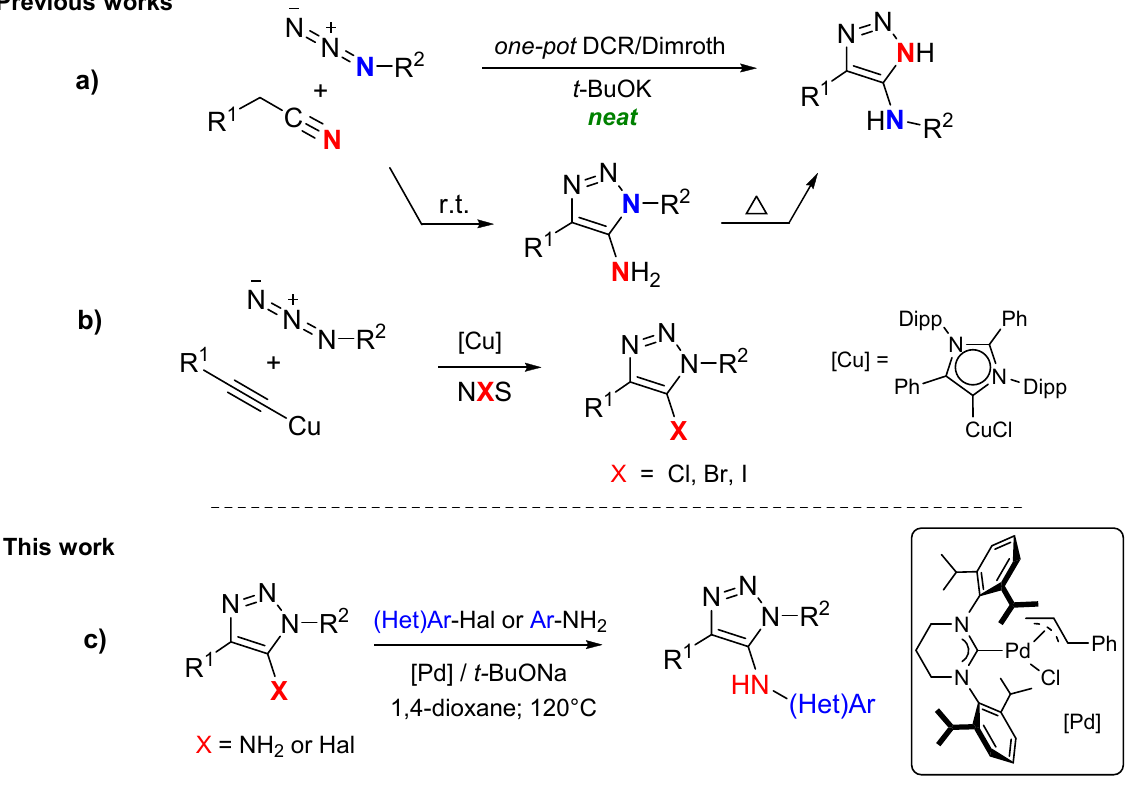
Scheme 2. Synthetic approach to 5-amino-1,2,3-triazoles ( a ), 5-halo-1,2,3-triazoles ( b ) and N -aryla- mino 1,2,3-triazoles ( c